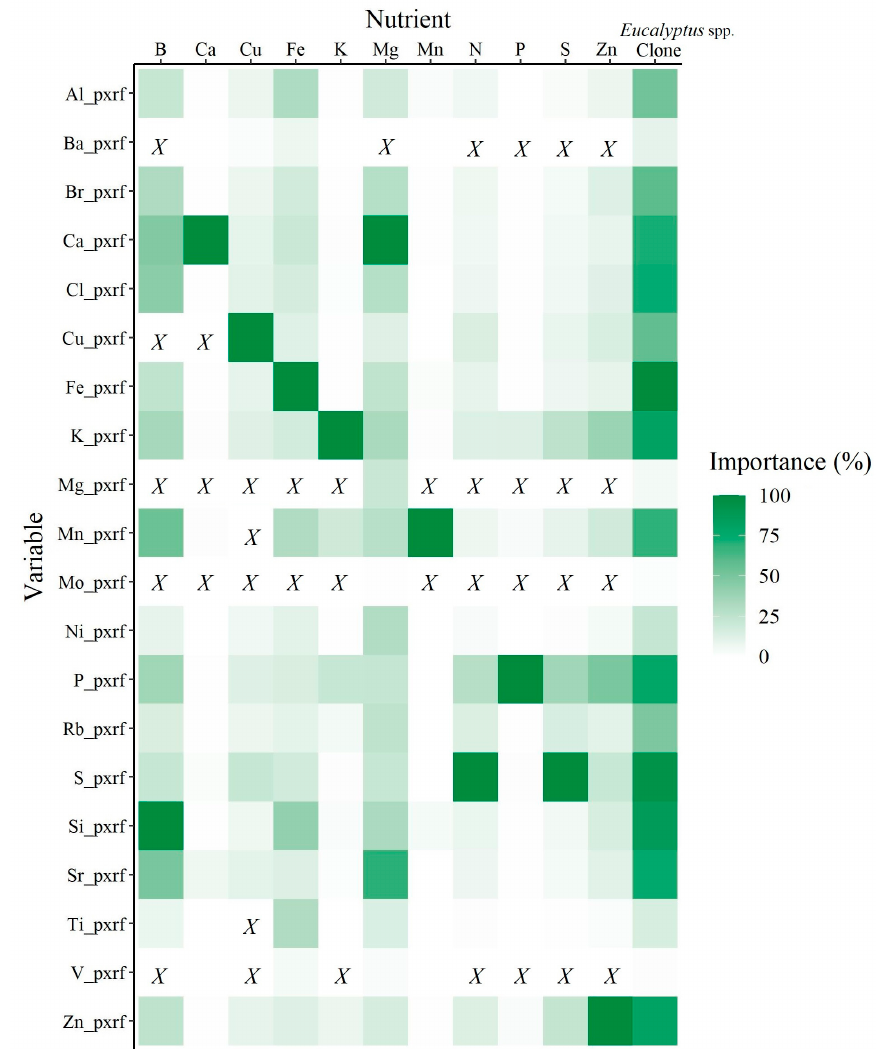
Figure 5. Explanatory variables used to predict the nutritional status of the Eucalyptus leaves and Eucalyptus spp. clones with their respective importance (%). X means that the variable was not used for the prediction model.